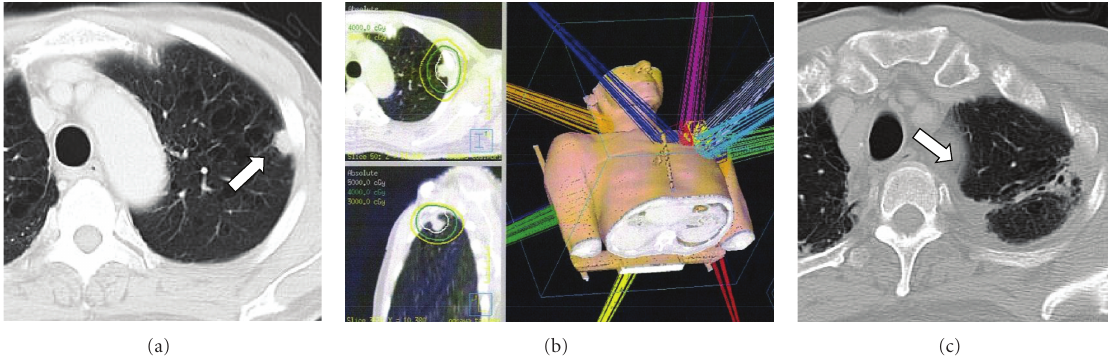
Figure 4: (a) CT of the left lung metastasis (arrow) before SBRT. (b) Dose distribution made with 10 noncoplanar beams for SBRT. The isodose lines shows total doses (in 4 fractions) of 50 Gy, 40 Gy, and 30Gy, respectively, from innermost area. (c) CT at 2 years after SBRT, showing partial response of the lesion (arrow) with focal radiation